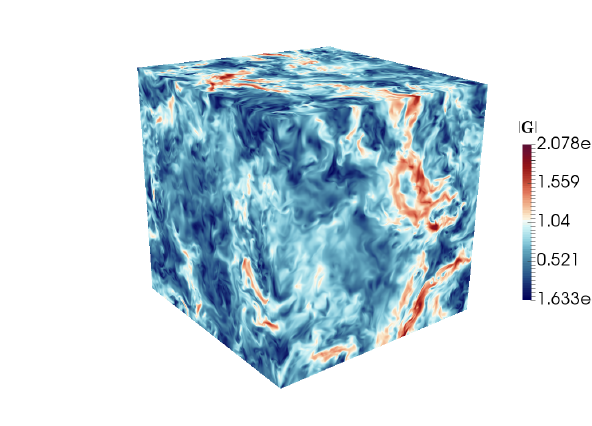
ρ u from ( a ) Run 1 ( ζ = 0.01) and ( b ) Run 3 ( ζ = 0.6). | |